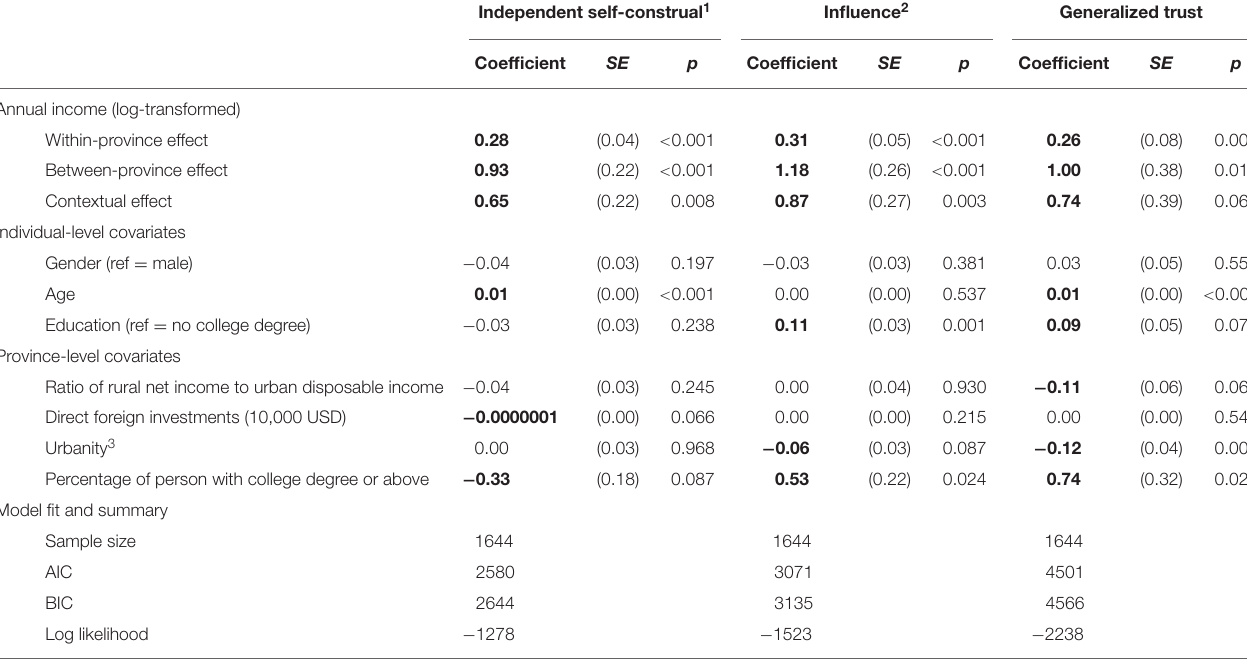
TABLE 3 | Multilevel analyses of independent self-construal, influence, and generalized trust.